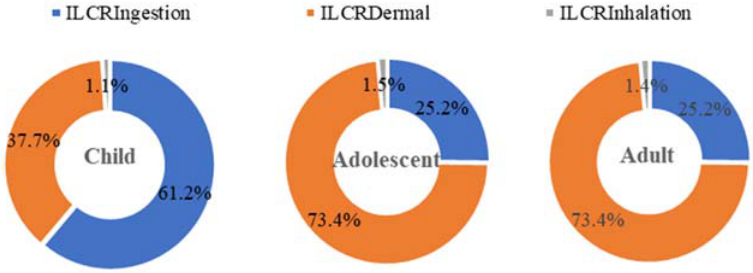
Figure 6. Contributions of different exposure pathways for children, adolescents, and adults calcu- lated by ILCR model.